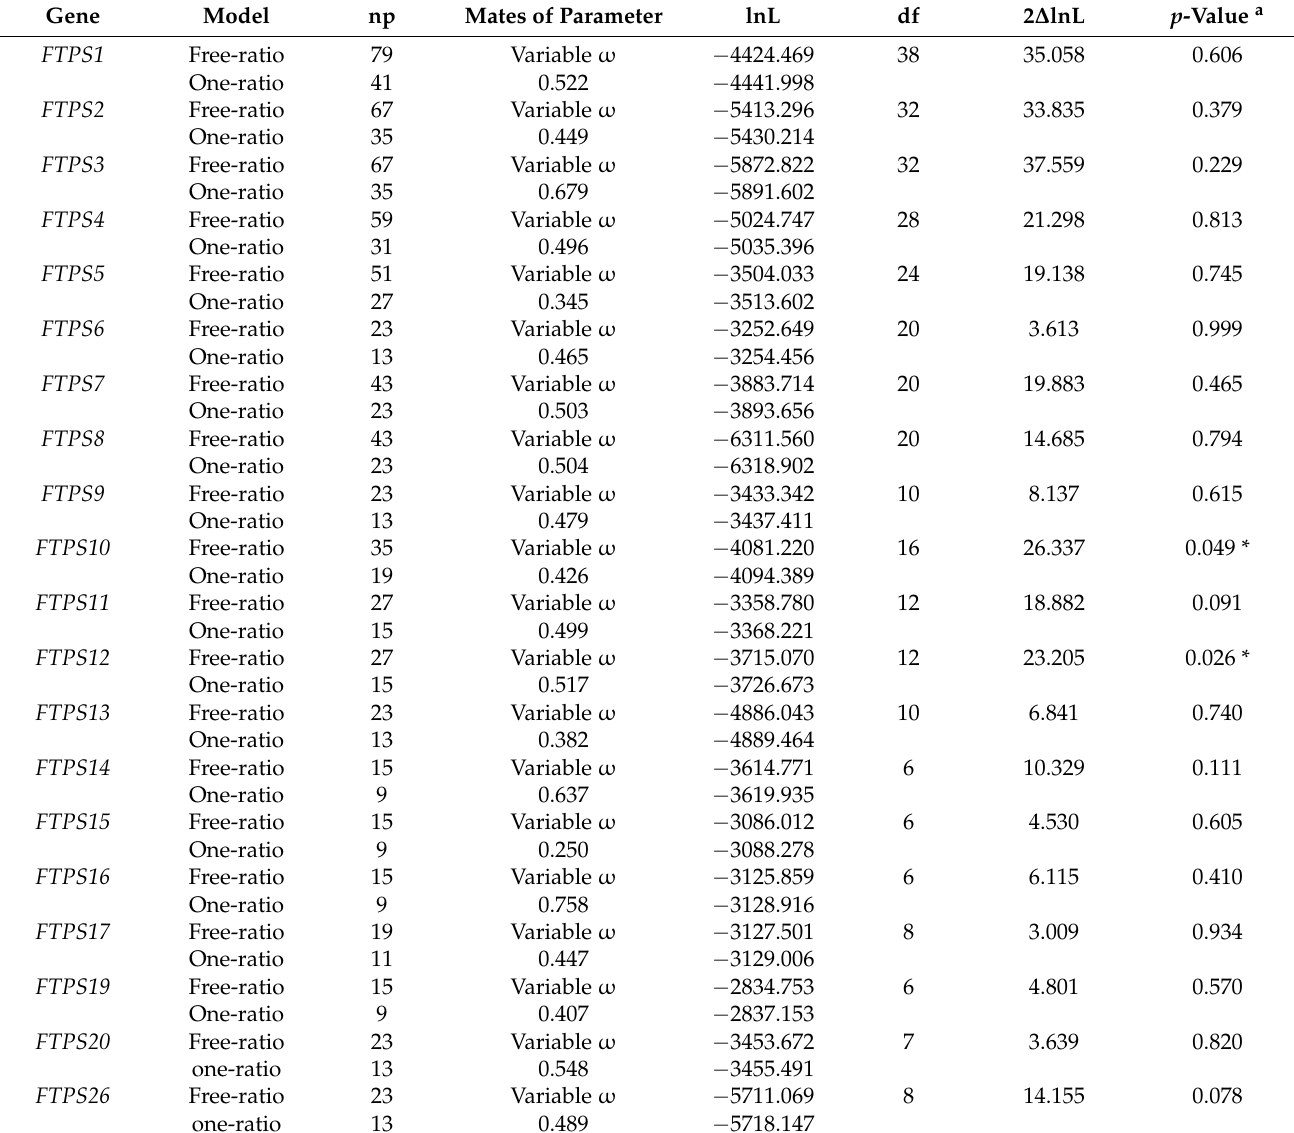
Table 2. Positive selection analysis of FTPS genes occurred in more than four species under branch model